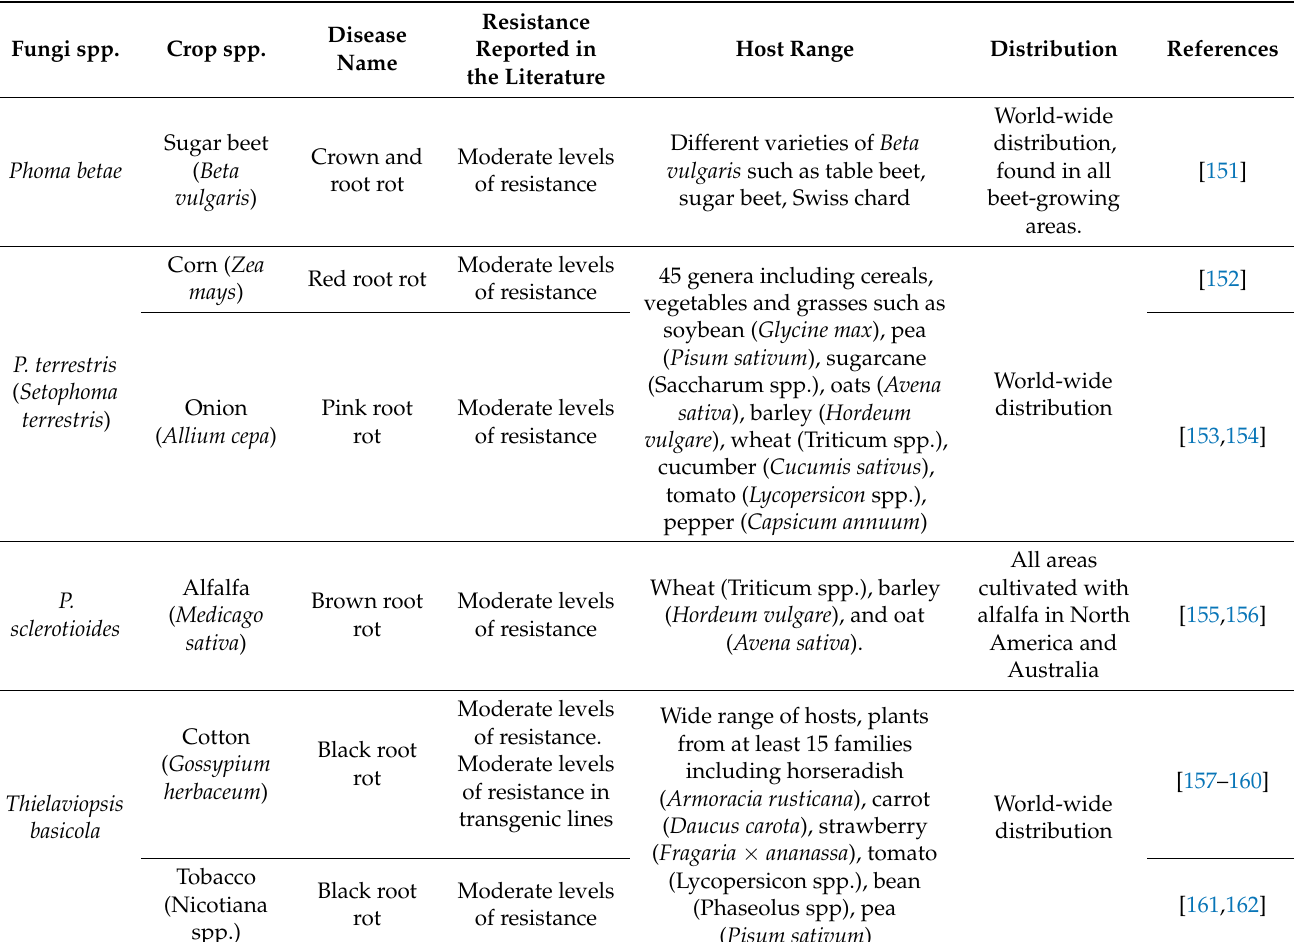
Table 3. Main crop species affected by fungus Phoma and Thielaviopsis basicola root rot.